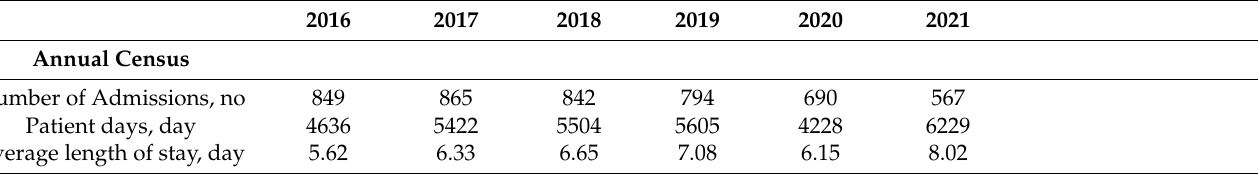
Table 1. Annual consumption of carbapenems in COVID-19 ICU and